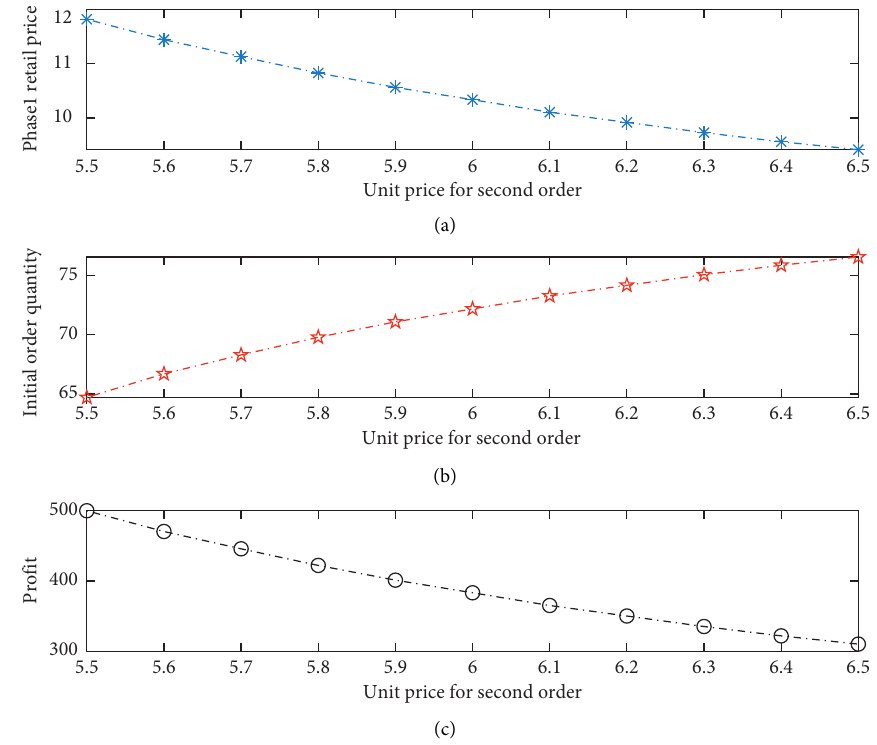
Figure 4: The relationship between the second-order price and the first retail price, order volume, and profit.